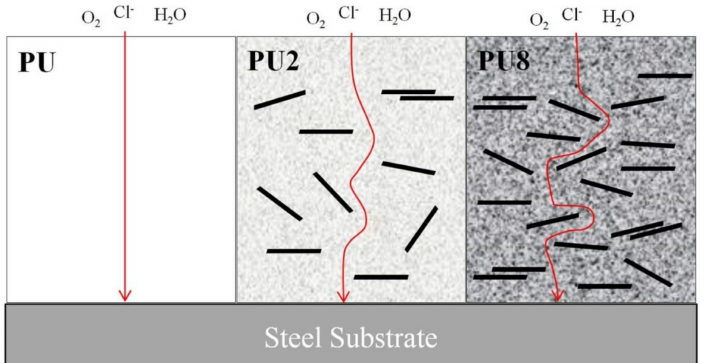
Figure 5. Schematic diagram of effect of Gr addition on barrier and corrosion protection performance of PU coating.